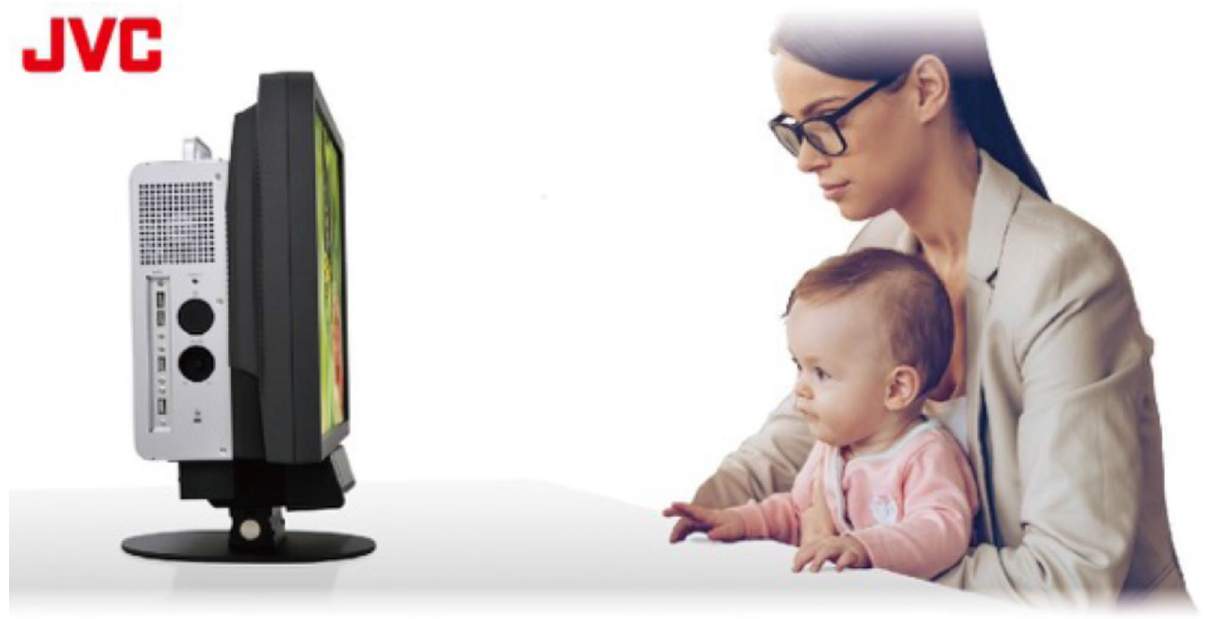
Figure 1. The image of the measurement by